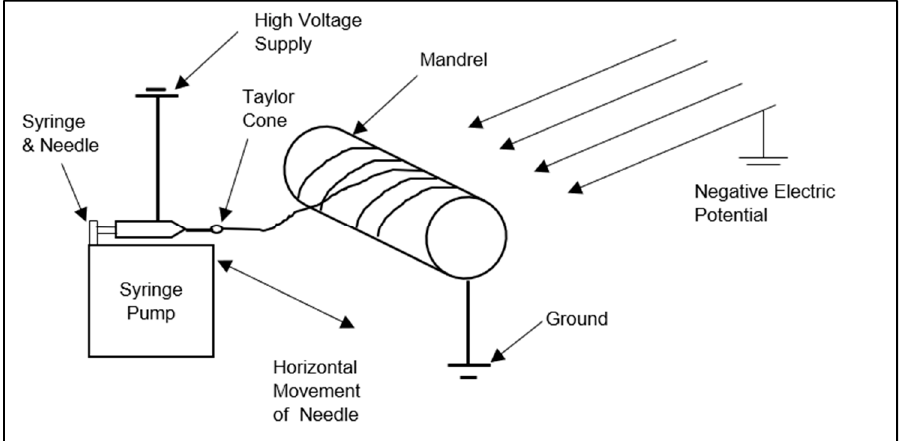
Figure 1. ( A ) Stirrer and heater and ( B ) yellowish solution.